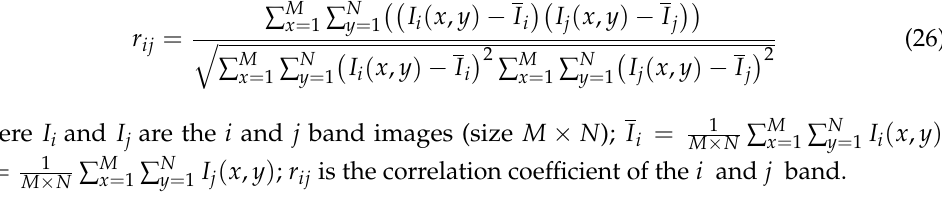
Table 3. Correlation statistics between neighboring bands of